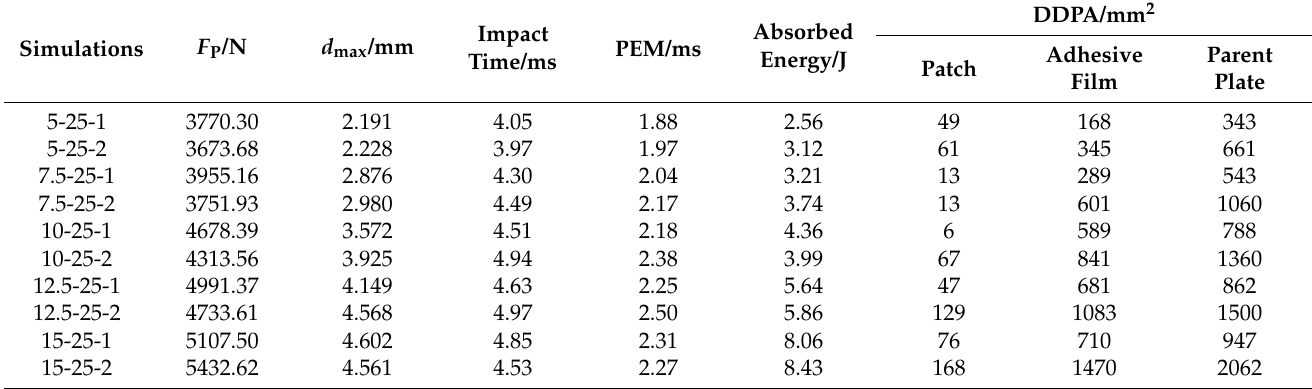
Table 5. Impact parameters under double impacts at the impact distance of 25 mm, with the impact energy of 5 J–15